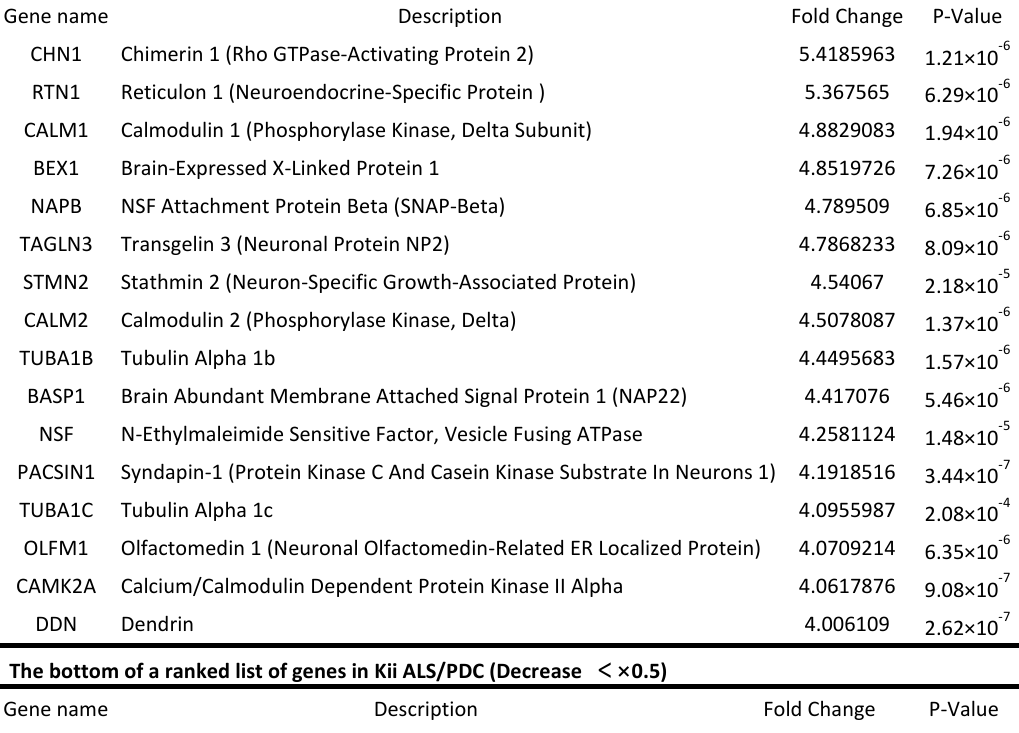
The bottom of a ranked list of genes in Kii ALS/PDC (Decrease ＜× 0.5)